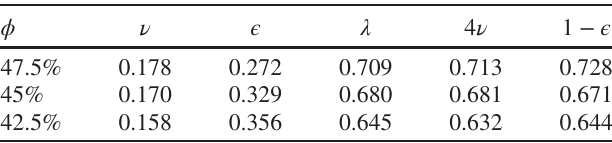
TABLE I. The values of λ , ϵ , and ν